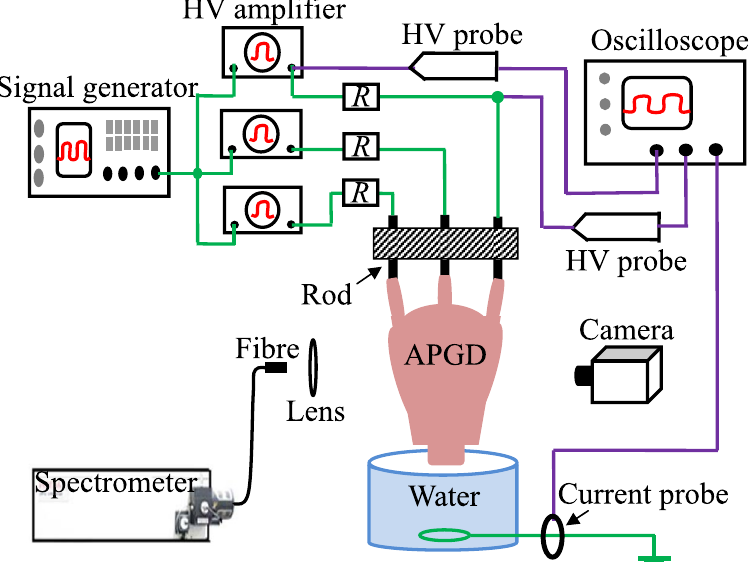
Figure 1. Schematic diagram of the experimental setup.